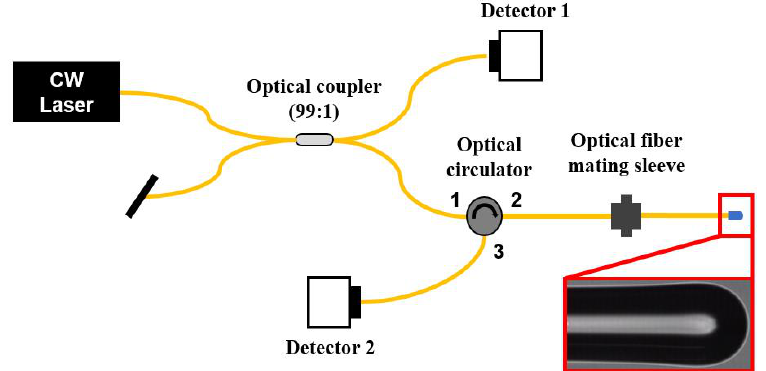
Figure 6. Schematic of the back-coupling efficiency measurement system. The intensity of the beam, reflected from the lens surface of a LOF and then back-coupled to the lead-in SMF, is measured.